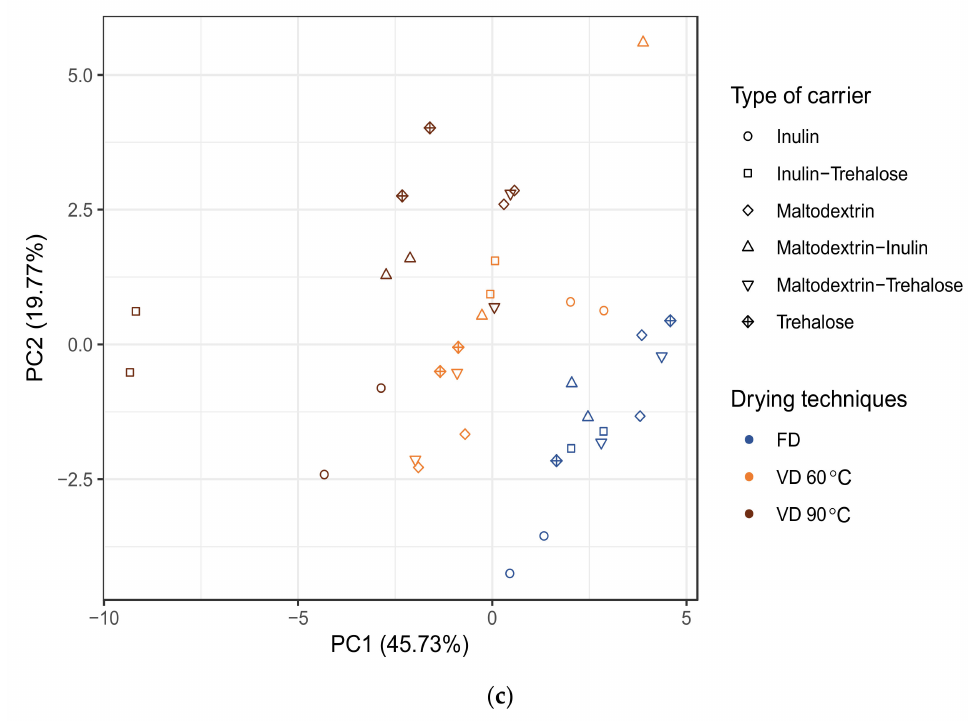
Figure 7. ( a ) The PCA biplot of the first two principal components. The marker colour corresponds to the drying techniques (i.e., freeze and vacuum drying at 60 and 90 ◦ C), while the length and the trans- parency of the arrows indicate the variance of the chemical properties of powders from chokeberry pomace extracts and their contributions to the principal components, respectively. Together, the first two principal components explain 65.50% of the variability; ( b ) The plot of normalised factor loadings; ( c ) Score plot in the space defined by the first two principal components illustrating the relations and trends of the chokeberry pomace extract powders gained after freeze and vacuum drying at 60 and 90 ◦ C with the addition of maltodextrin (M), inulin (I), trehalose (T), maltodextrin—inulin (M—I), maltodextrin—trehalose (M—T), and inulin—trehalose